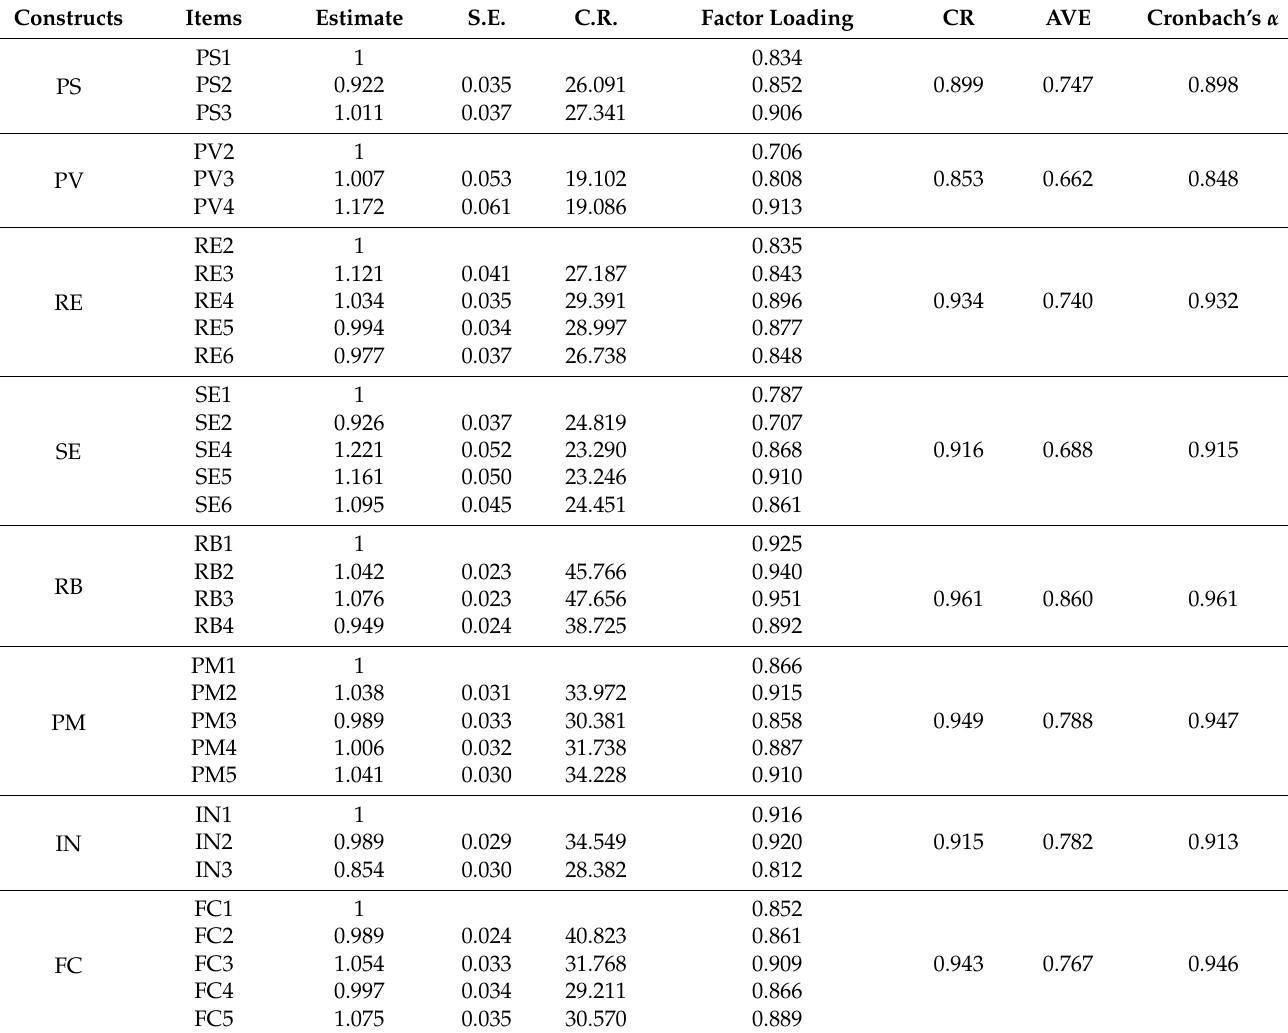
Table 3. Confirmatory factor analysis results for measurement model.